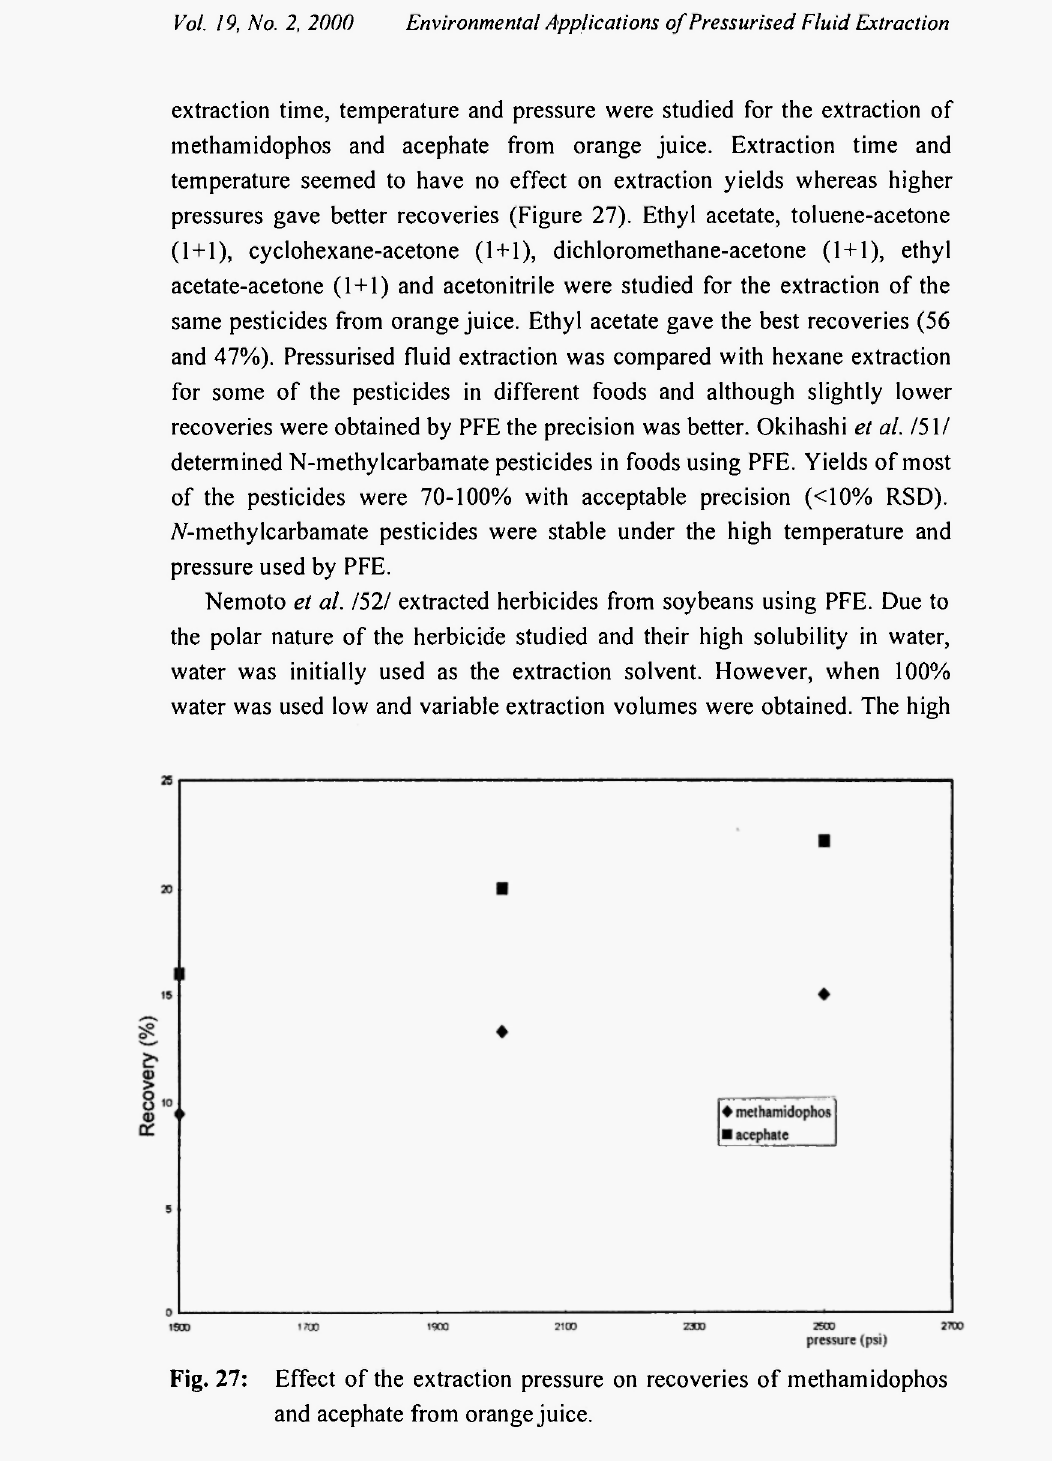
Fig. 27: Effect of the extraction pressure on recoveries of methamidophos and acephate from orange